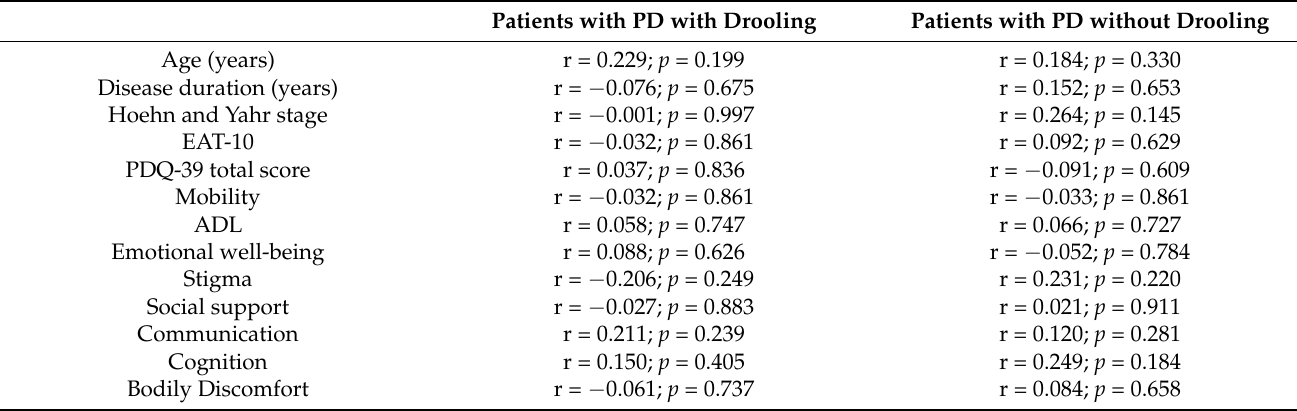
Table 2. Associations between Sialorrhea Clinical Scale for Parkinson’s disease and clinical variables in patients with and without drooling. Patients with PD with Drooling Patients with PD without